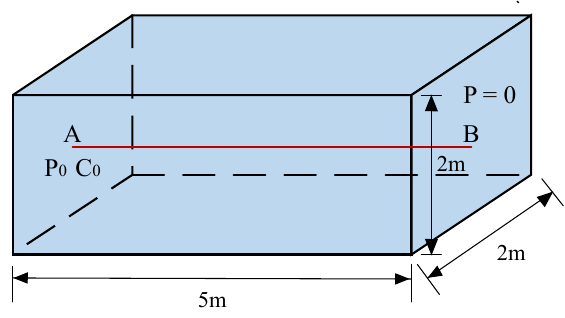
Figure 4. 3D porous rock medium.